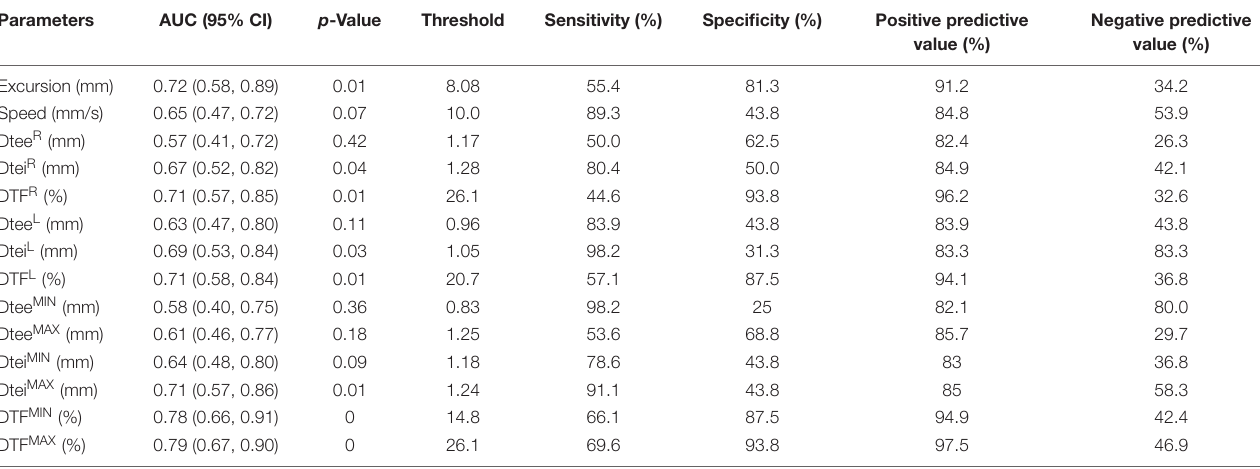
Dtee R , right diaphragm thickness at the end of expiration; Dtee L , left diaphragm thickness at the end of expiration; Dtee MIN , minimum diaphragm thickness at the end of expiration; Dtee MAX , maximum diaphragm thickness at the end of expiration; Dtei R , right diaphragm thickness at the end of inspiration; Dtei L , left diaphragm thickness at the end of inspiration; Dtei MIN , minimum diaphragm thickness at the end of inspiration; Dtei MAX , maximum diaphragm thickness at the end of inspiration; DTF R , right diaphragm thickening fraction; DTF L , left diaphragm thickening fraction; DTF MIN , minimum diaphragm thickening fraction; DTF MAX , maximum diaphragm thickening